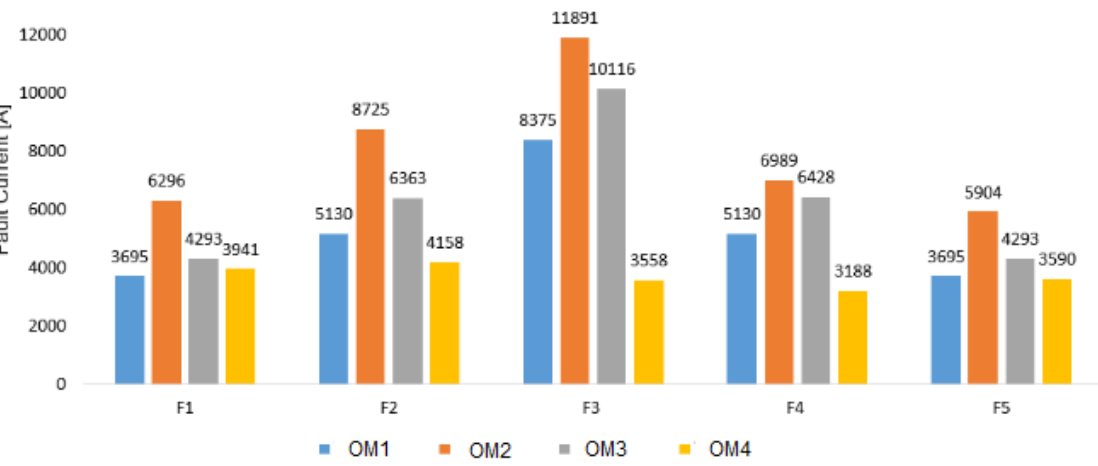
Figure 5. Short-circuit levels for different operational modes